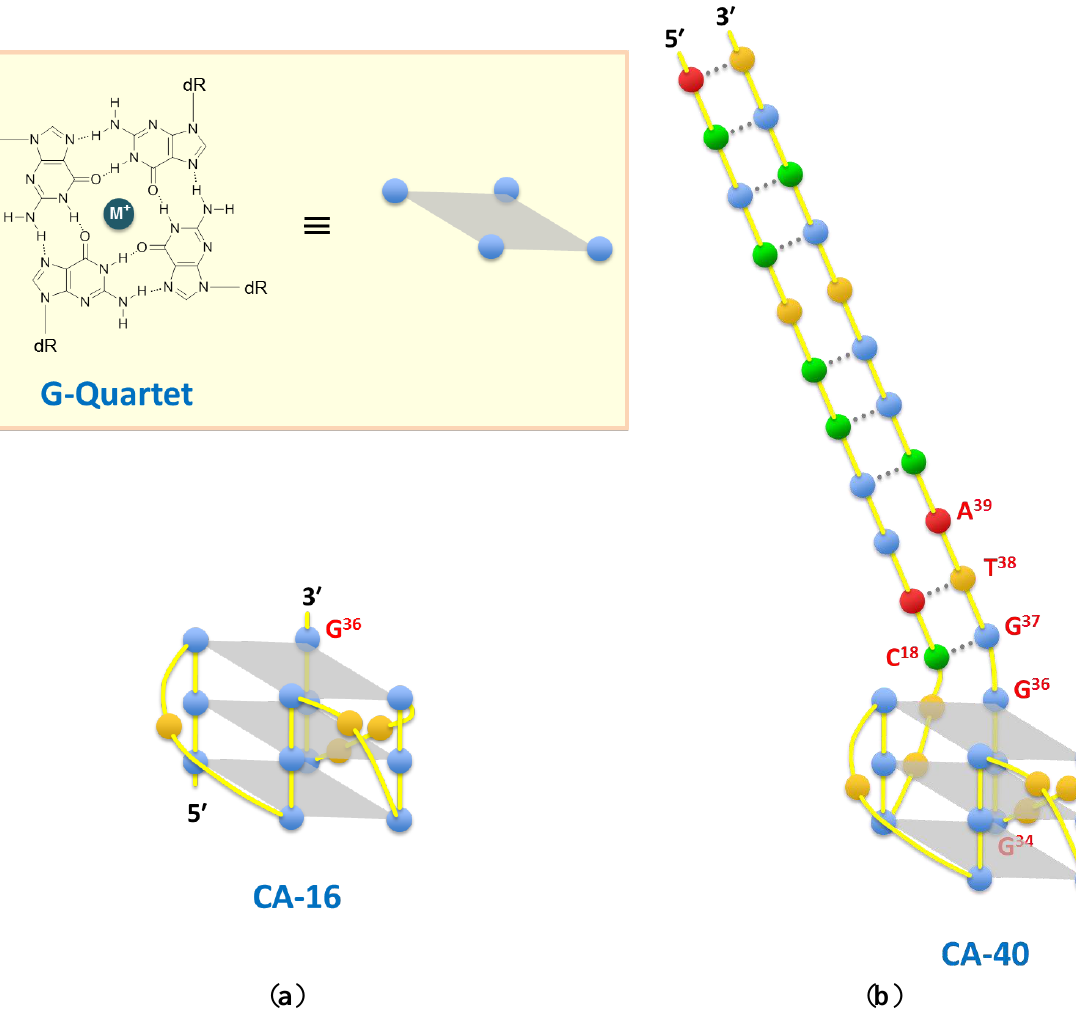
16-mer parallel G-quadruplex, CA-16 (lower). ( b ) Cartoon of a putative conformation